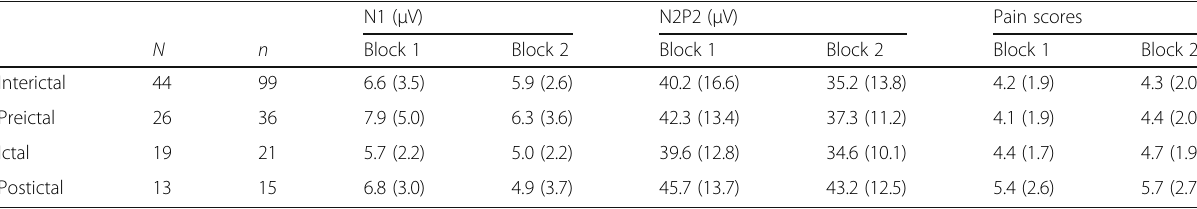
Table 2 N1 and N2P2-amplitudes, and pain scores by phase and